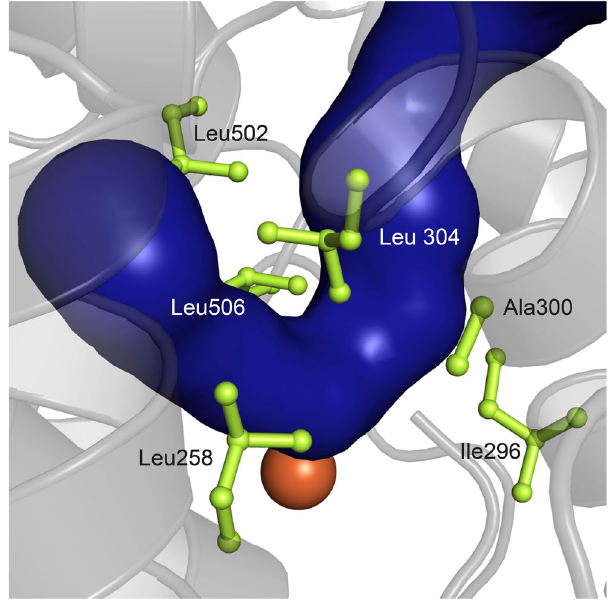
Figure 2. Residues forming a clamp-like structure around the CspLOX2 active site. The putative substrate- binding channel is shown in blue, the catalytic iron as orange sphere and the side chains of the crucial active site amino acids in light